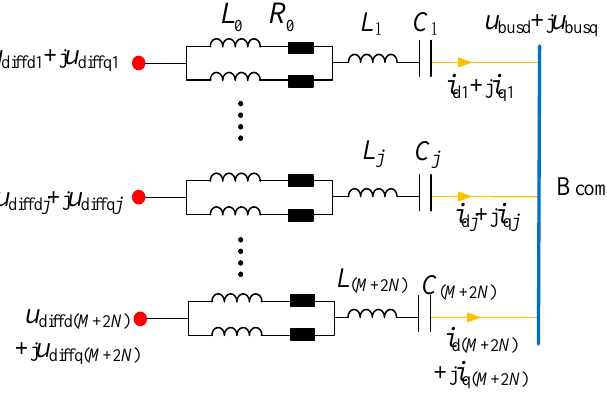
voltage u diff j output by MMC j on the valve side [18], i d j and i q j are the dq axis components B com voltage u bus . L 0 and R 0 are the MMC j arm inductor and resistor respectively [22–25].